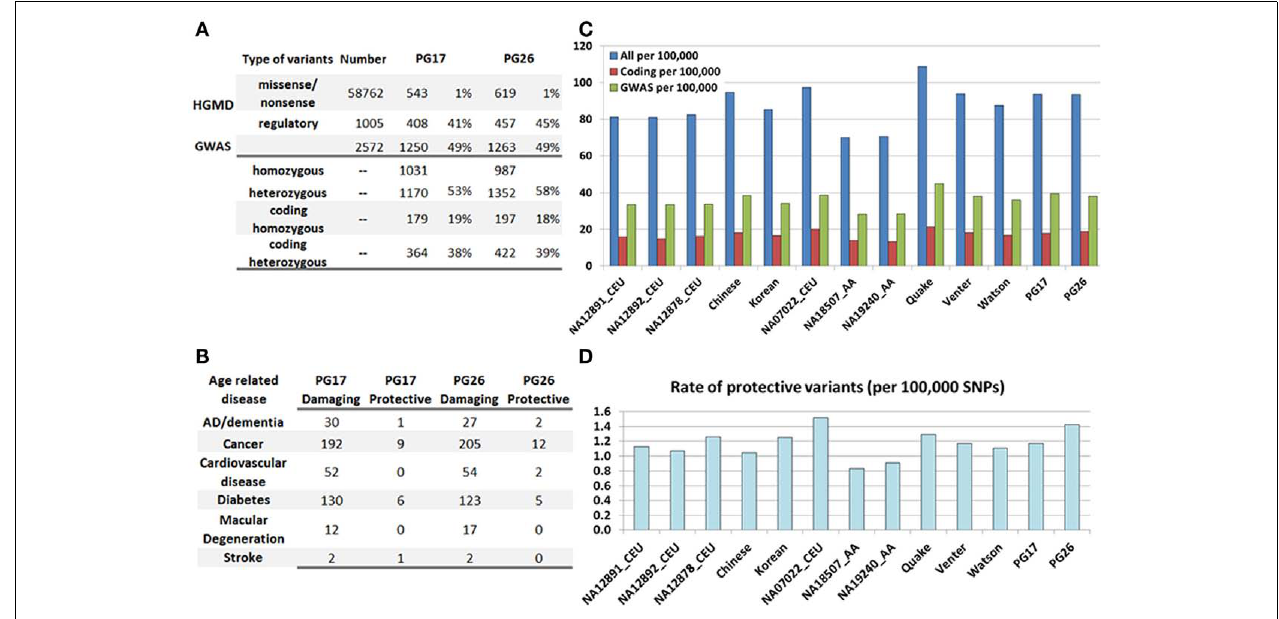
analysis the genomes of NA12878 and NA18507 that were sequenced with SOLID. Blue: all SNPs from HGMD and GWAS; red: only coding SNPs from HGMD; green: only SNPs from GWAS. Rates are per 100,000 SNPs. (D) . Rate of protective variants in PG17 and PG26 and 11 other whole genome sequences.The major difference seems to be race related rather than subject